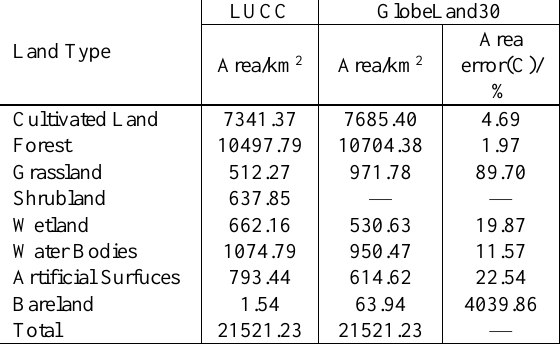
Table 2. Area statistics and error coefficient of different land